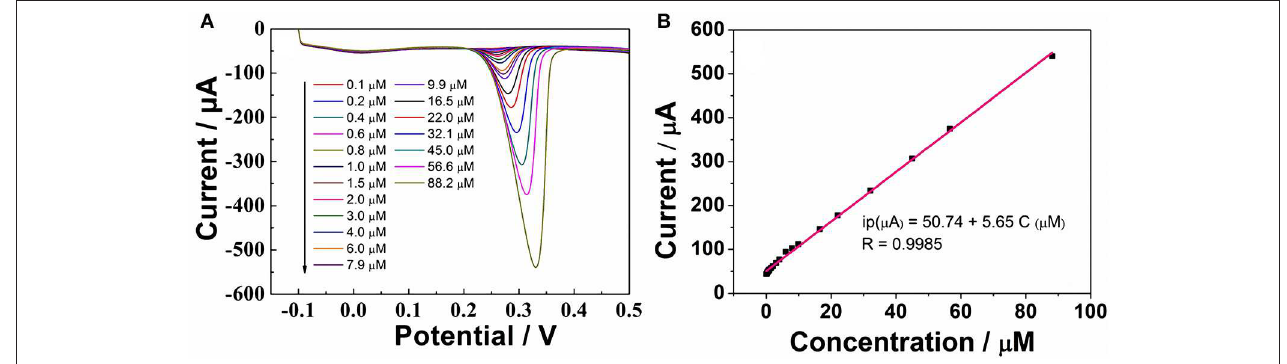
FIGURE 6 | (A) DPV response for the different concentrations of UA on ErGO-CP6/GCE in 0.2M PBS (pH 6.8). (B) The calibration curve of UA.